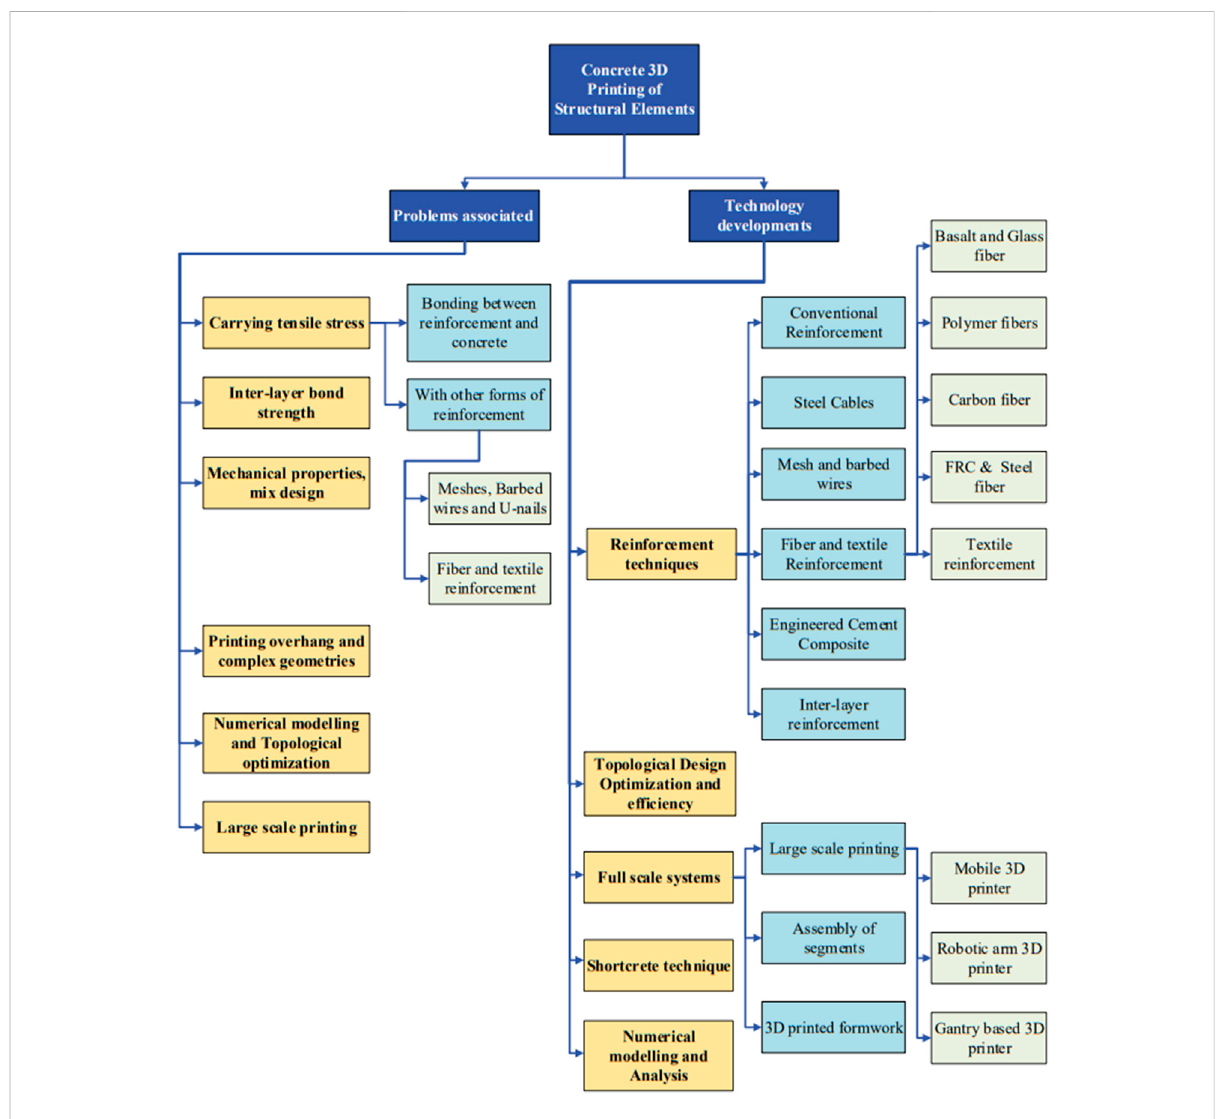
FIGURE 1 Methodology and focus of literature